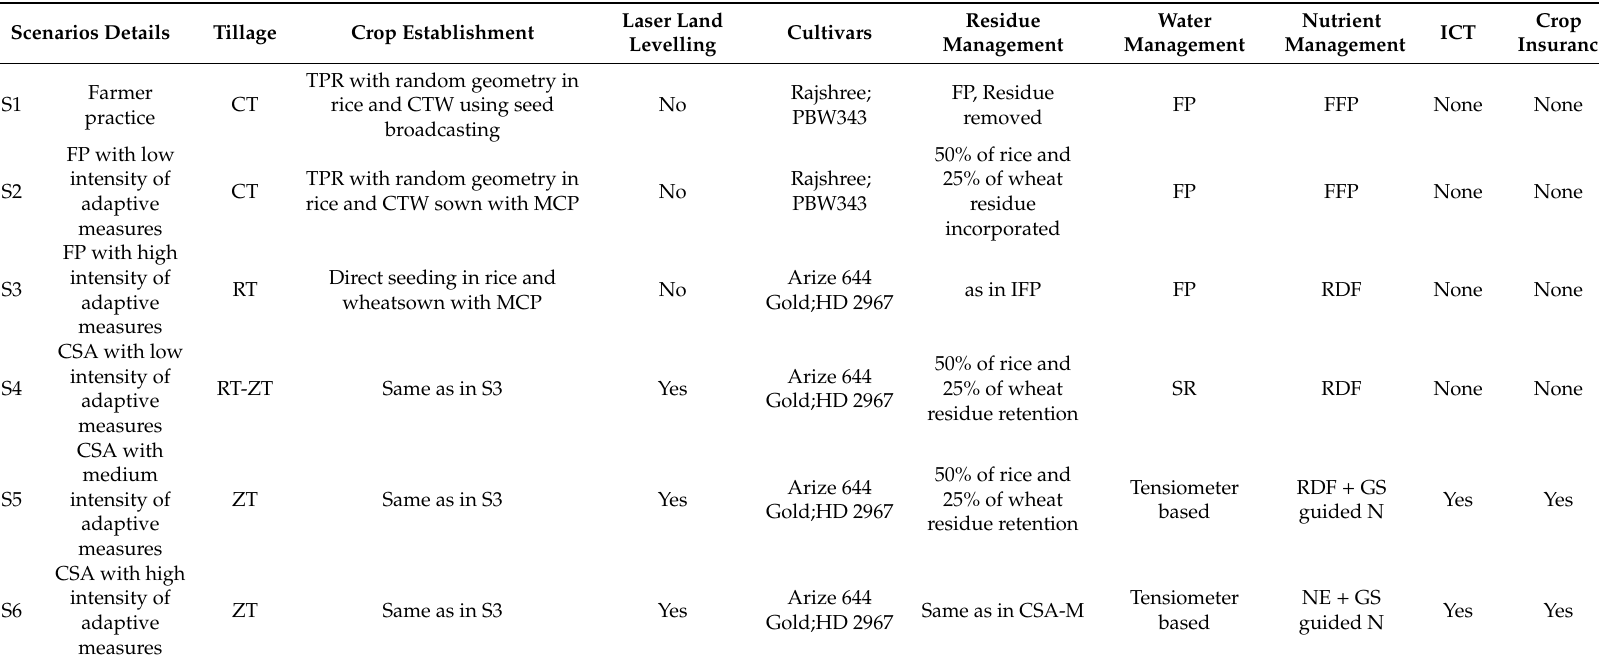
Table 1. Notations and description of management protocols adopted under di ff erent scenarios in rice-wheat